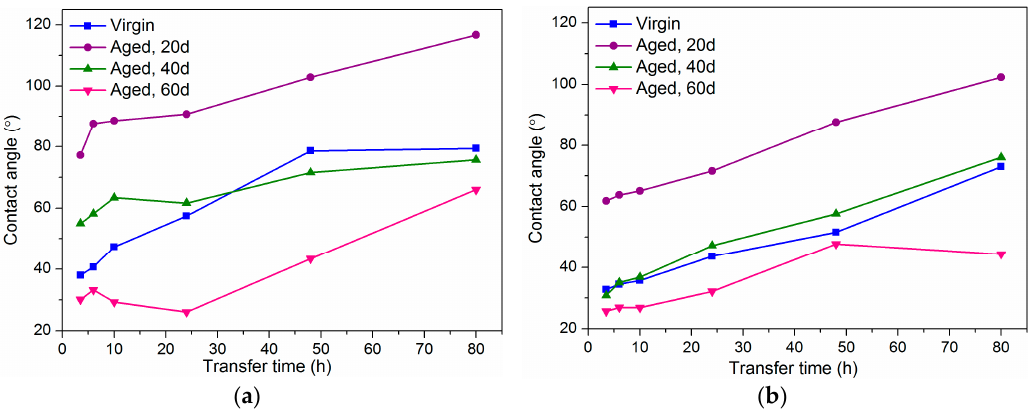
Figure 6. Contact angle of pollution layer covered on samples at different transfer times. ( a ) Sample 1; and ( b ) Sample 2.